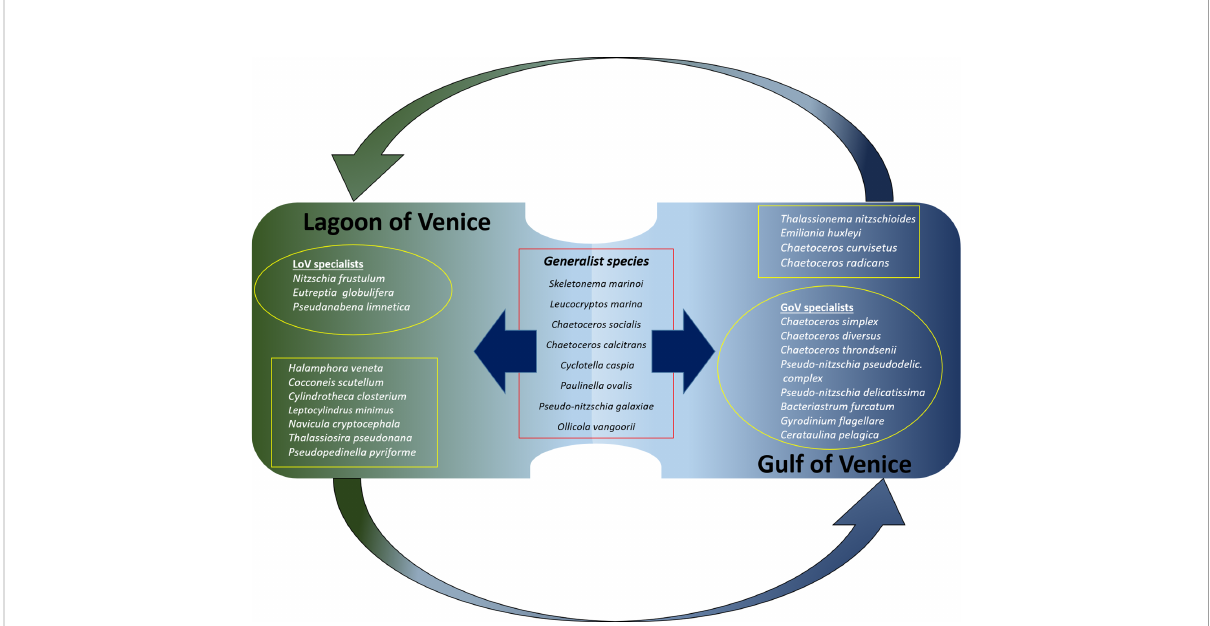
FIGURE 8 Diagram showing the main generalists (in the centre of the picture) and specialists in the LoV and in the GoV. The specialists framed in the squares are those that are also found, in low abundance and at low frequency, in the other environment; those in the circles are found only in one of the two